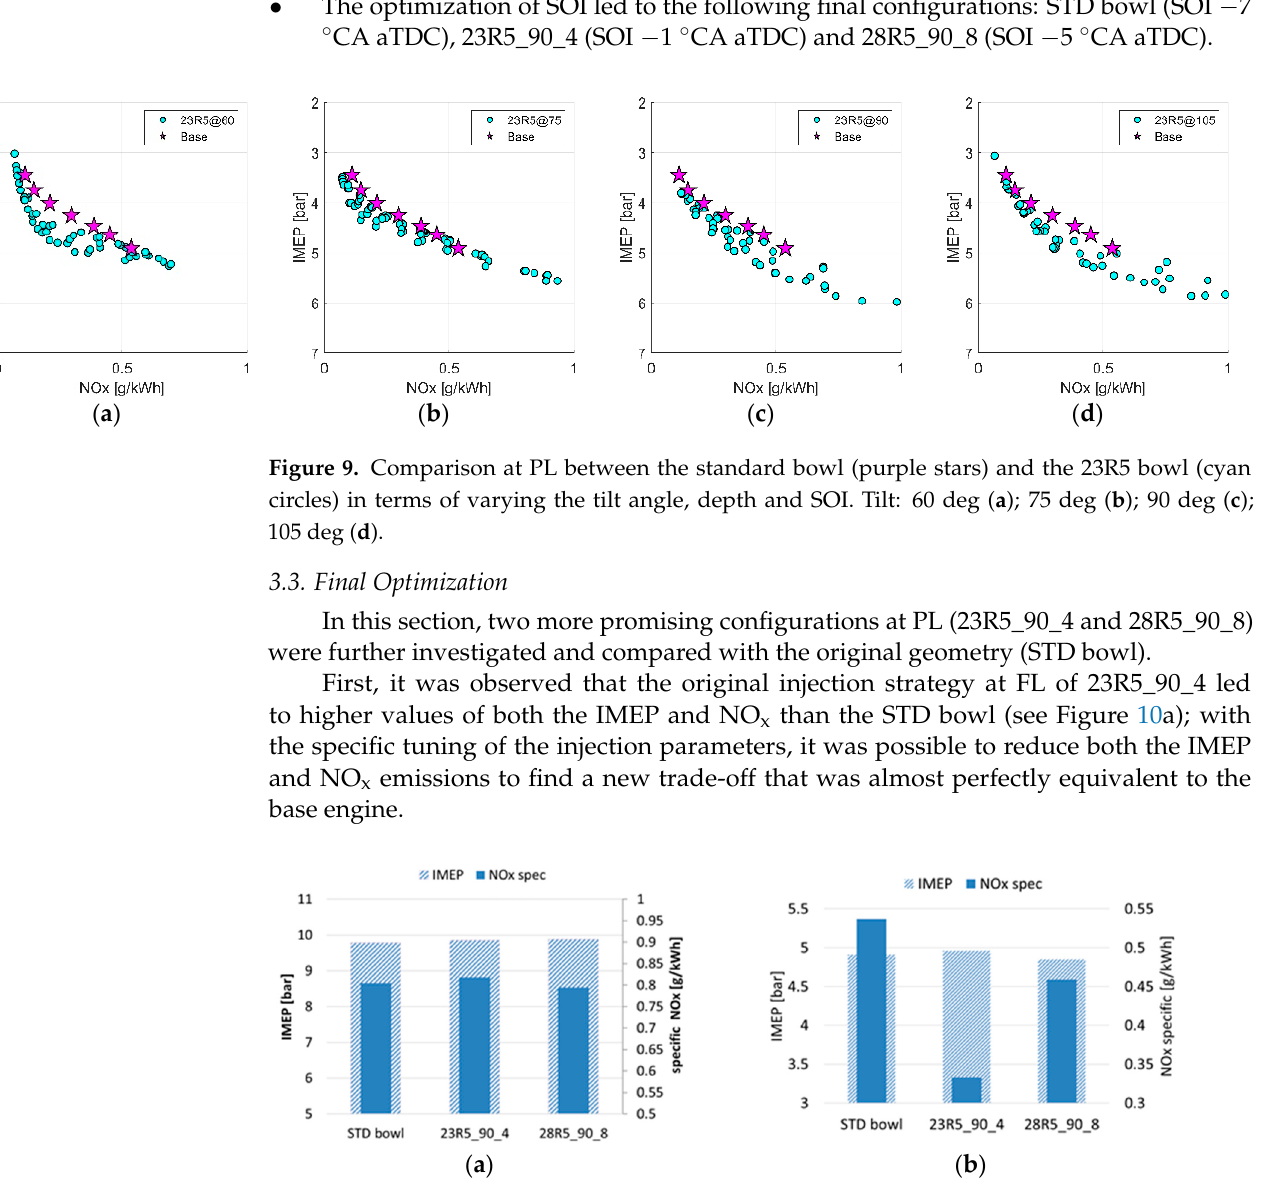
Figure 10. Comparison between the bowls at full load ( a ) and partial load ( b ): IMEP and NO x emis- sions .